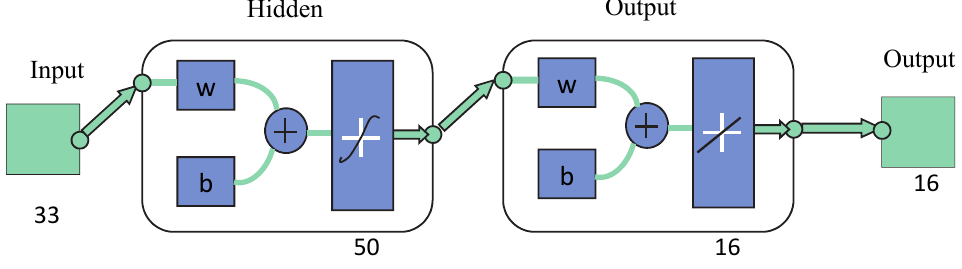
Fig. 3. A view of the model developed with neuron